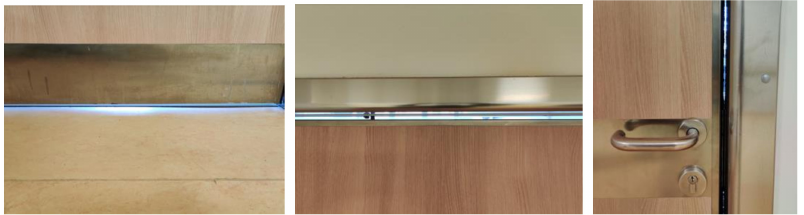
Figure 2. Details of the roto-translating door between the room and the corridor with no bottom re- bate.